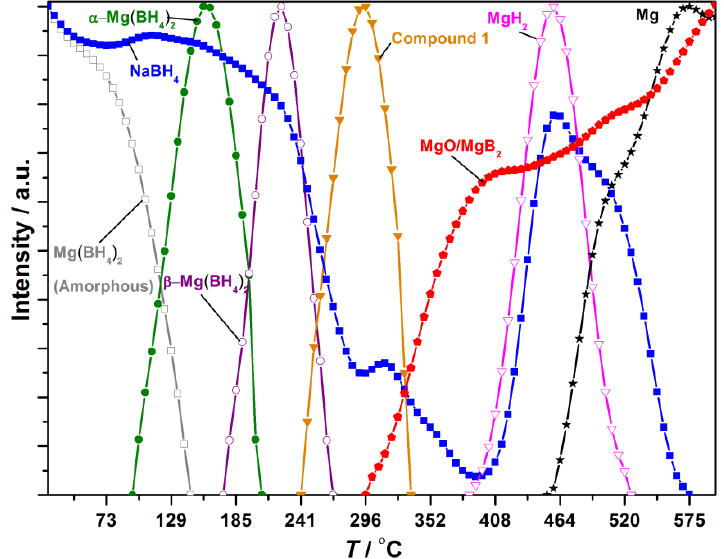
Figure 5. Normalized diffracted intensities of selected Bragg peaks from the compounds observed during the in situ synchrotron radiation powder X-ray diffraction (SR-PXD) experiment of 0.665NaBH 4 ‒ 0.335Mg(BH 4 ) 2 . Legend: NaBH 4 (blue square), Mg(BH 4 ) 2 amorphous (grey square), α -Mg(BH 4 ) 2 (green circle), β -Mg(BH 4 ) 2 (purple circle), Compound 1 (orange triangle), MgH 2 (magenta triangle), MgO/MgB 2 (red pentagon), Mg (black